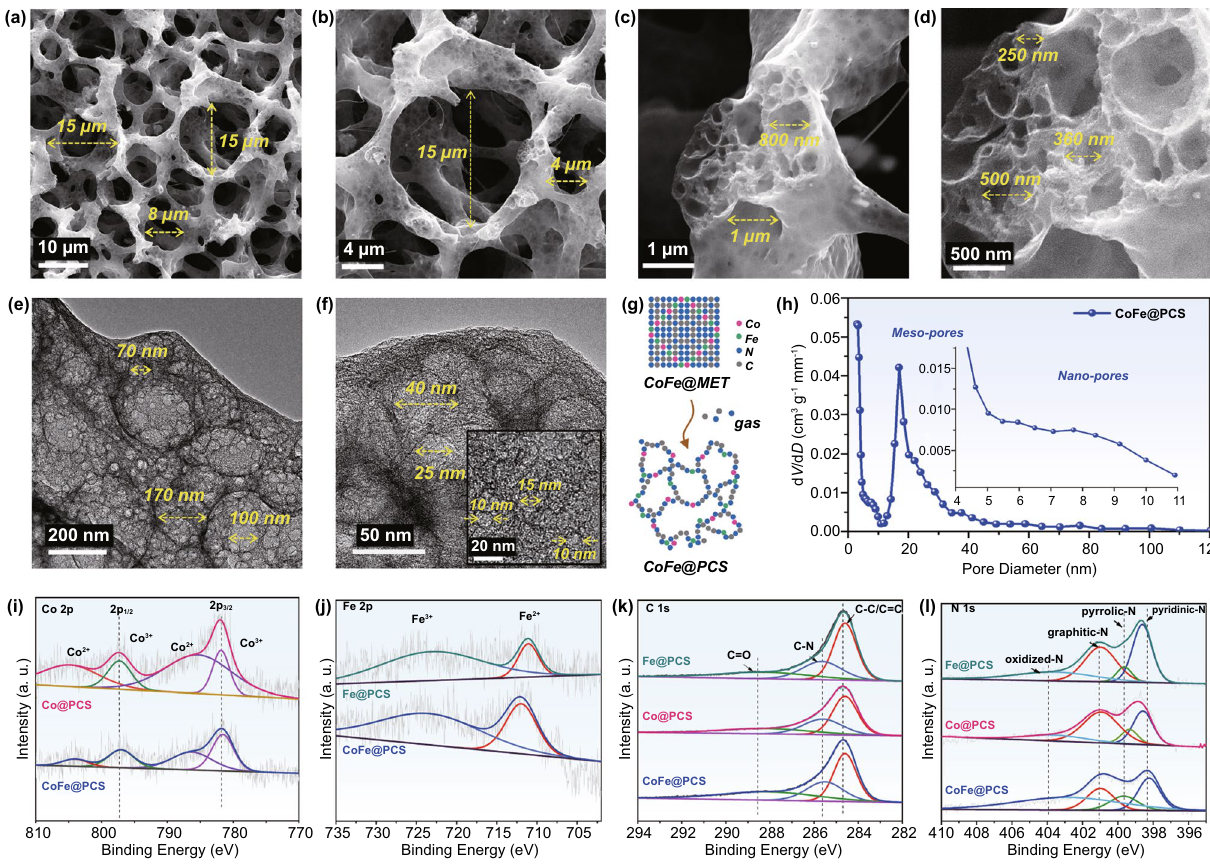
Fig. 1 Porous characterization of the 3D noncontinuous carbon matrix in CoFe@PCS. a‑d SEM images with the pores of 200 nm–15 μm. e–f TEM images with pores of 10–200 nm. g Scheme of formation of the pores in the CoFe@PCS. h Pore diameter distribution curves. i‑l The XPS spectra of Co 2 p ( i ), Fe 2 p ( j ), C 1 s ( k ), N 1 s ( l ) for Fe@PCS, Co@PCS,